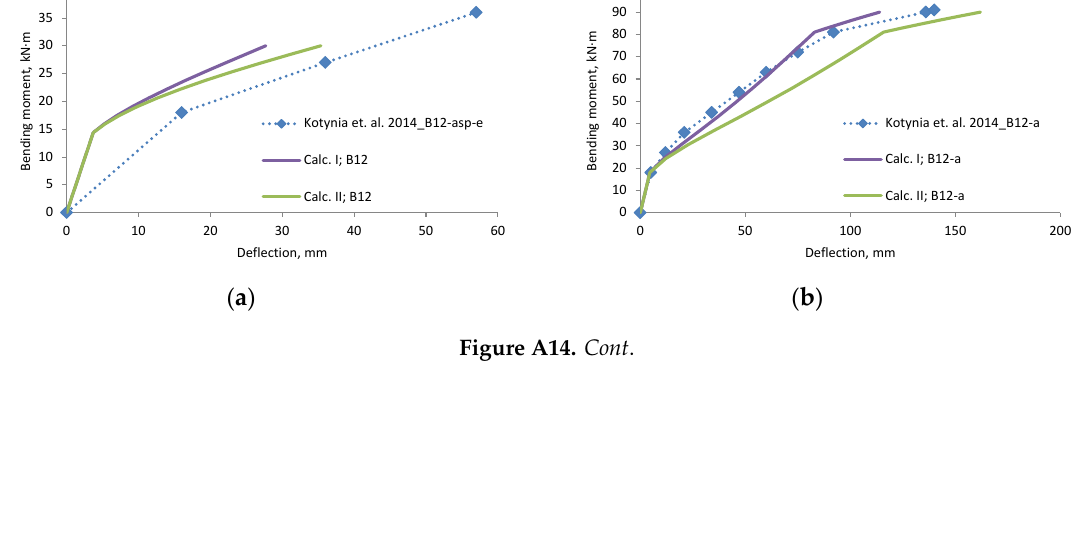
Figure A14. Cont